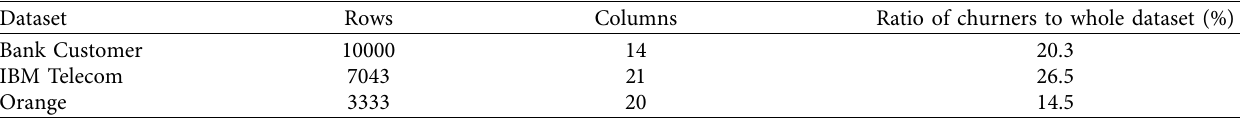
Table 5: Data resources summary.